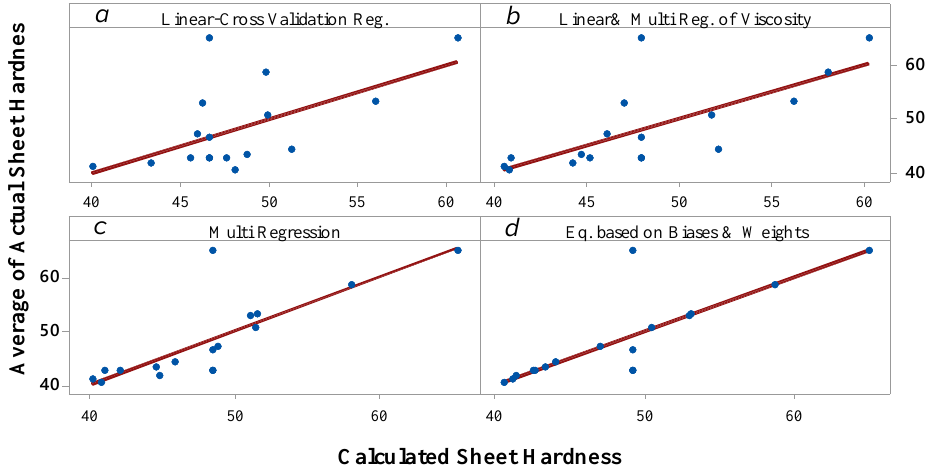
Figure 11. Actual and calculated values obtained with equations of ( a ) Linear Cross-Validation Regression, ( b ) Linear Cross-Validation with Multiple Regression of Viscosity, ( c ) Multiple Regression, and ( d ) Equation Based on Biases and Weights.